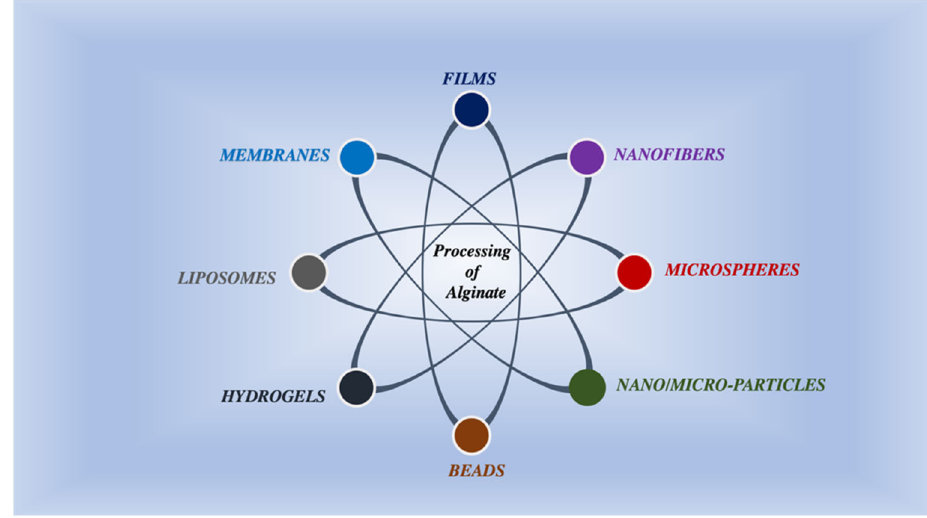
Figure 4. Diagrammatic representation of ALG formulations into diverse forms.